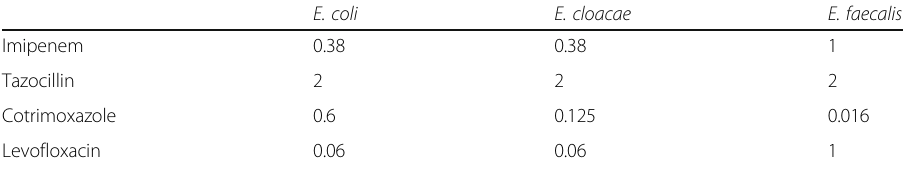
Table 2 In vitro susceptibility (minimal inhibitory concentration ( μ g/mL)) of the organisms identified in the blood culture in our CLP rats ( n = 16) to antimicrobial